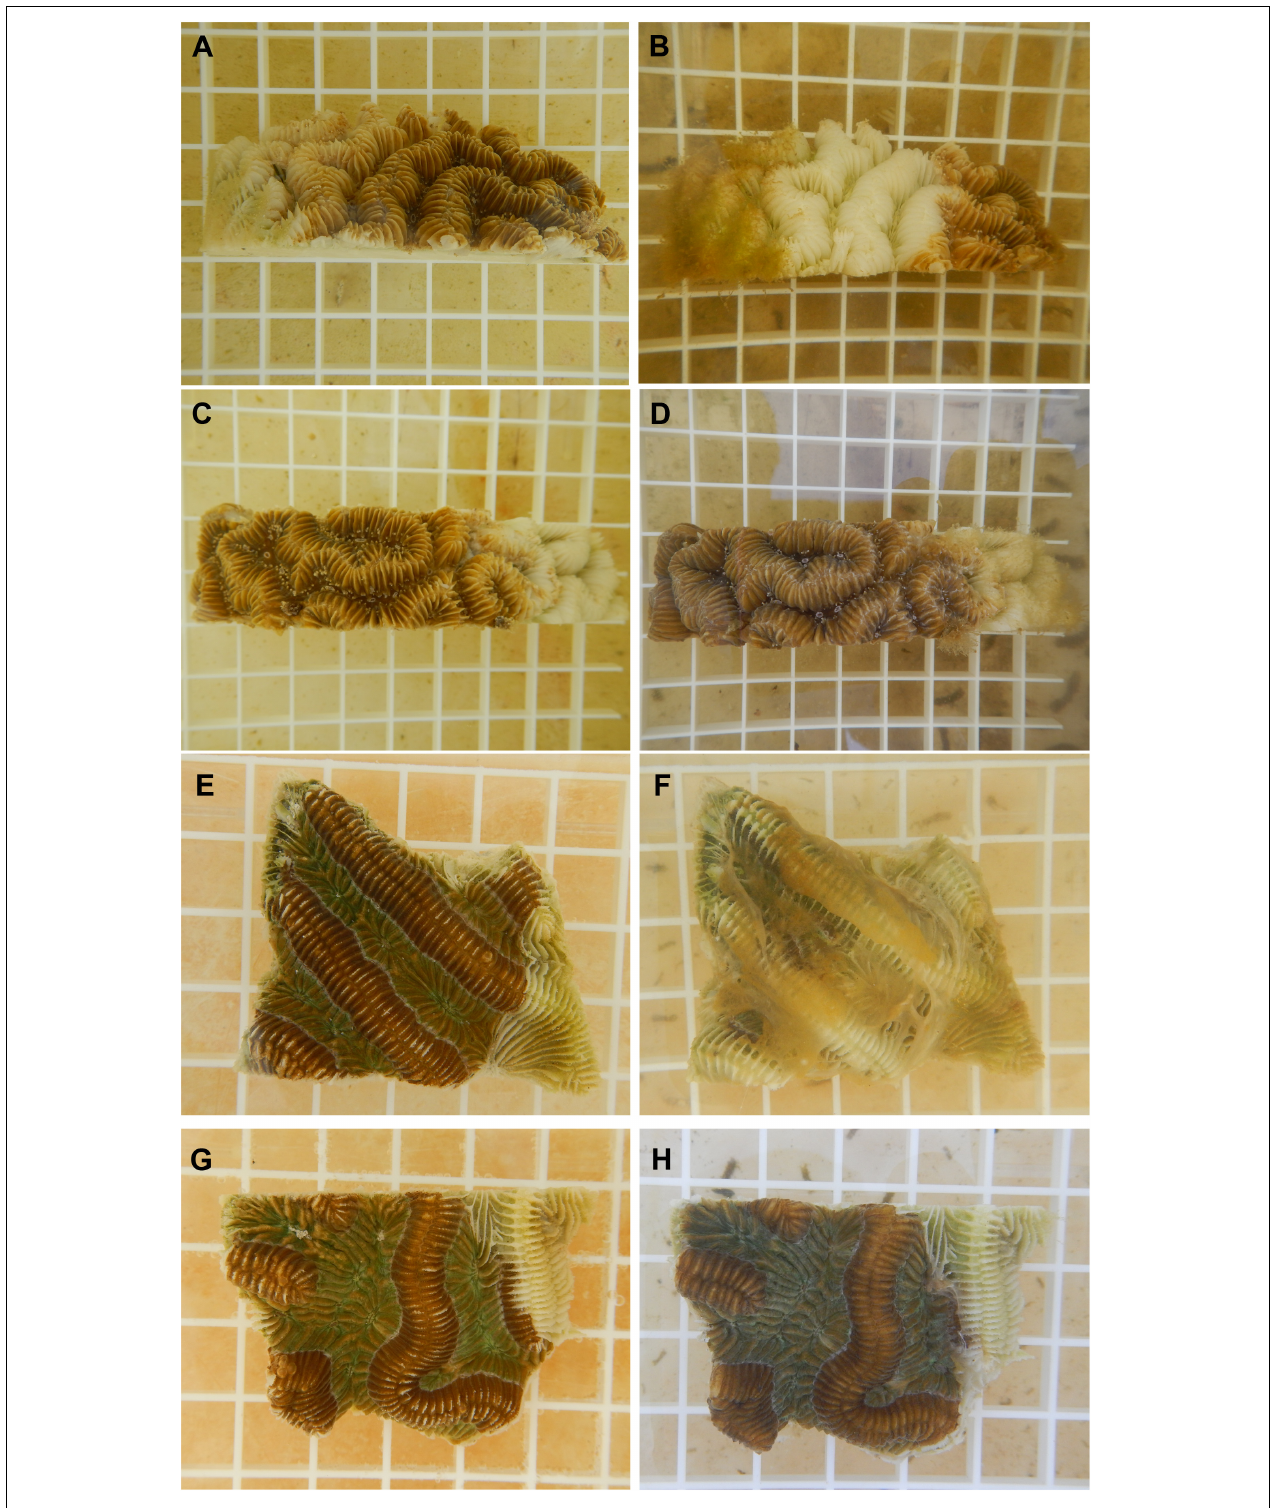
FIGURE 9 | Antibiotic treatment of diseased Meandrina meandrites and Colpophyllia natans . (A) A diseased non-treated M. meandrites fragment at the start of the experiment and (B) the same fragment after 8 days. (C) A diseased M. meandrites fragment before treatment with amoxicillin and kanamycin, and (D) the same fragment 8 days after treatment. (E) A diseased non-treated C. natans fragment at the start of the experiment, and (F) the same fragment after 4 days. (G) A diseased C. natans fragment before treatment with nalidixic acid, and (H) the same fragment 8 days after treatment. Each square on the grid is 1 × 1 cm.